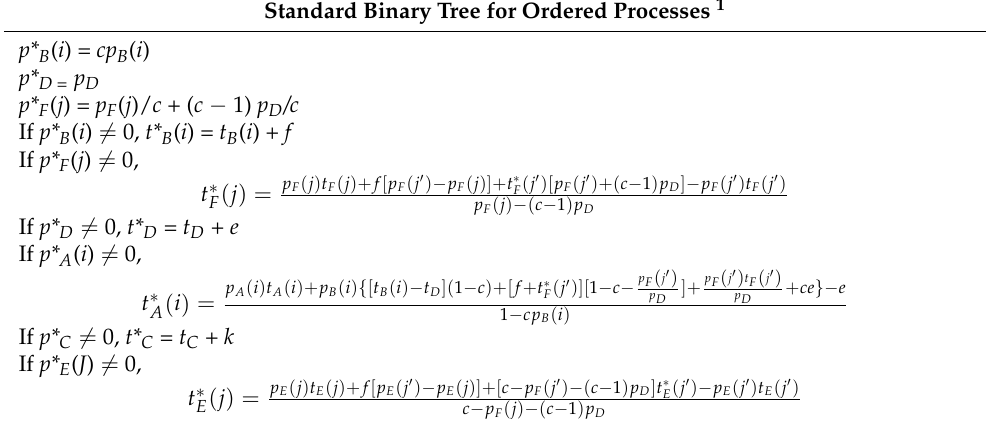
Table 2. Admissible Transformations of Parameters. Standard Binary Tree for Ordered Processes 1